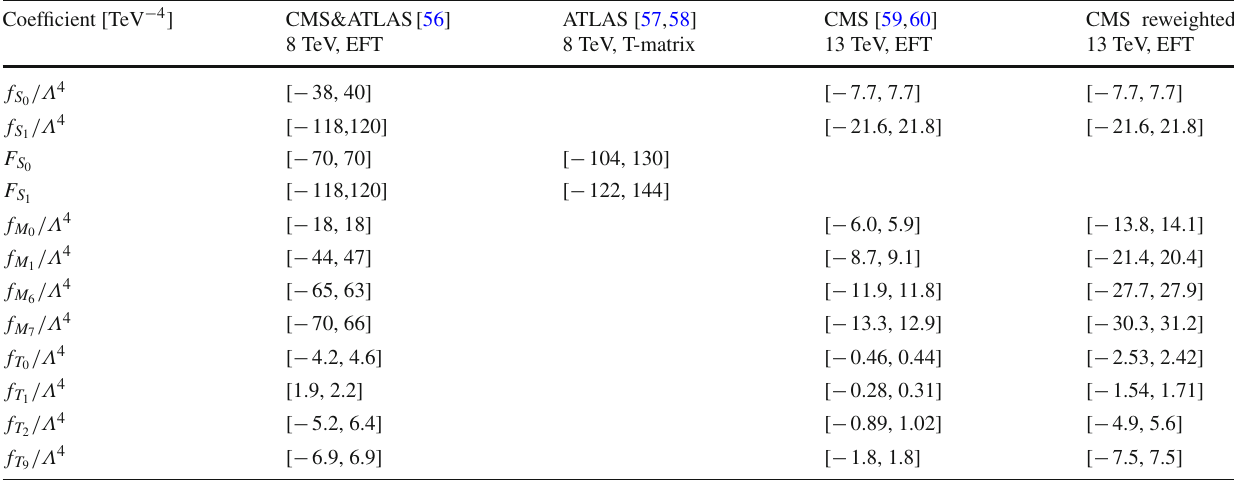
Table 3 Observed limits of ATLAS and CMS of complete LHC data at √ s = 8TeV and current observed limits of CMS at thenaiveEFTmodelandtheT-matrixmodel.Thelastcolumnshowsthe